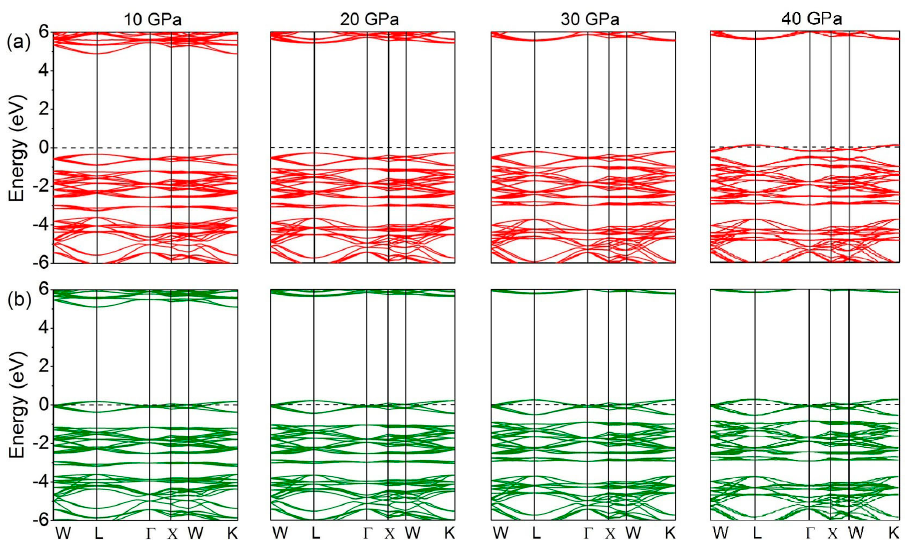
Figure 8. Band structure of GaFe(CN) 6 under different pressures. ( a ) Majority-spin; ( b ) minority-spin.